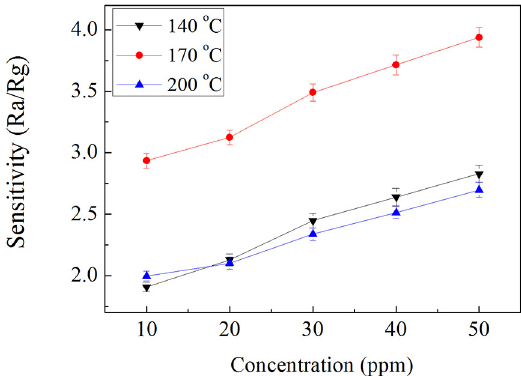
MoO sensor to different nitrogen 2 6